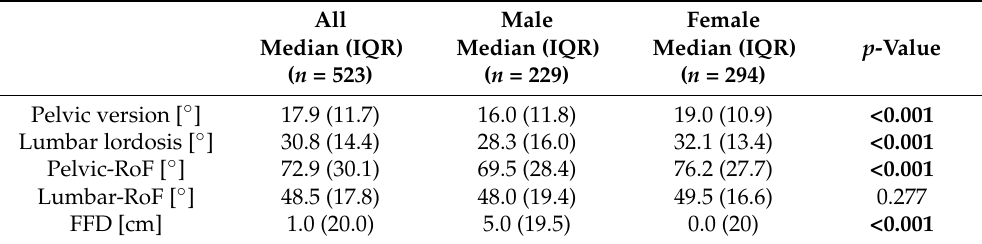
Table 2. Sex differences in pelvic version, lumbar lordosis, pelvic- and lumbar-RoF between male and female participants.